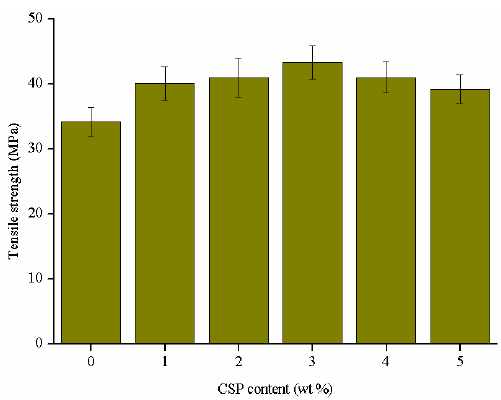
Figure 5 . Tensile strength of the epoxy thermosets modified with different contents of CSPs.